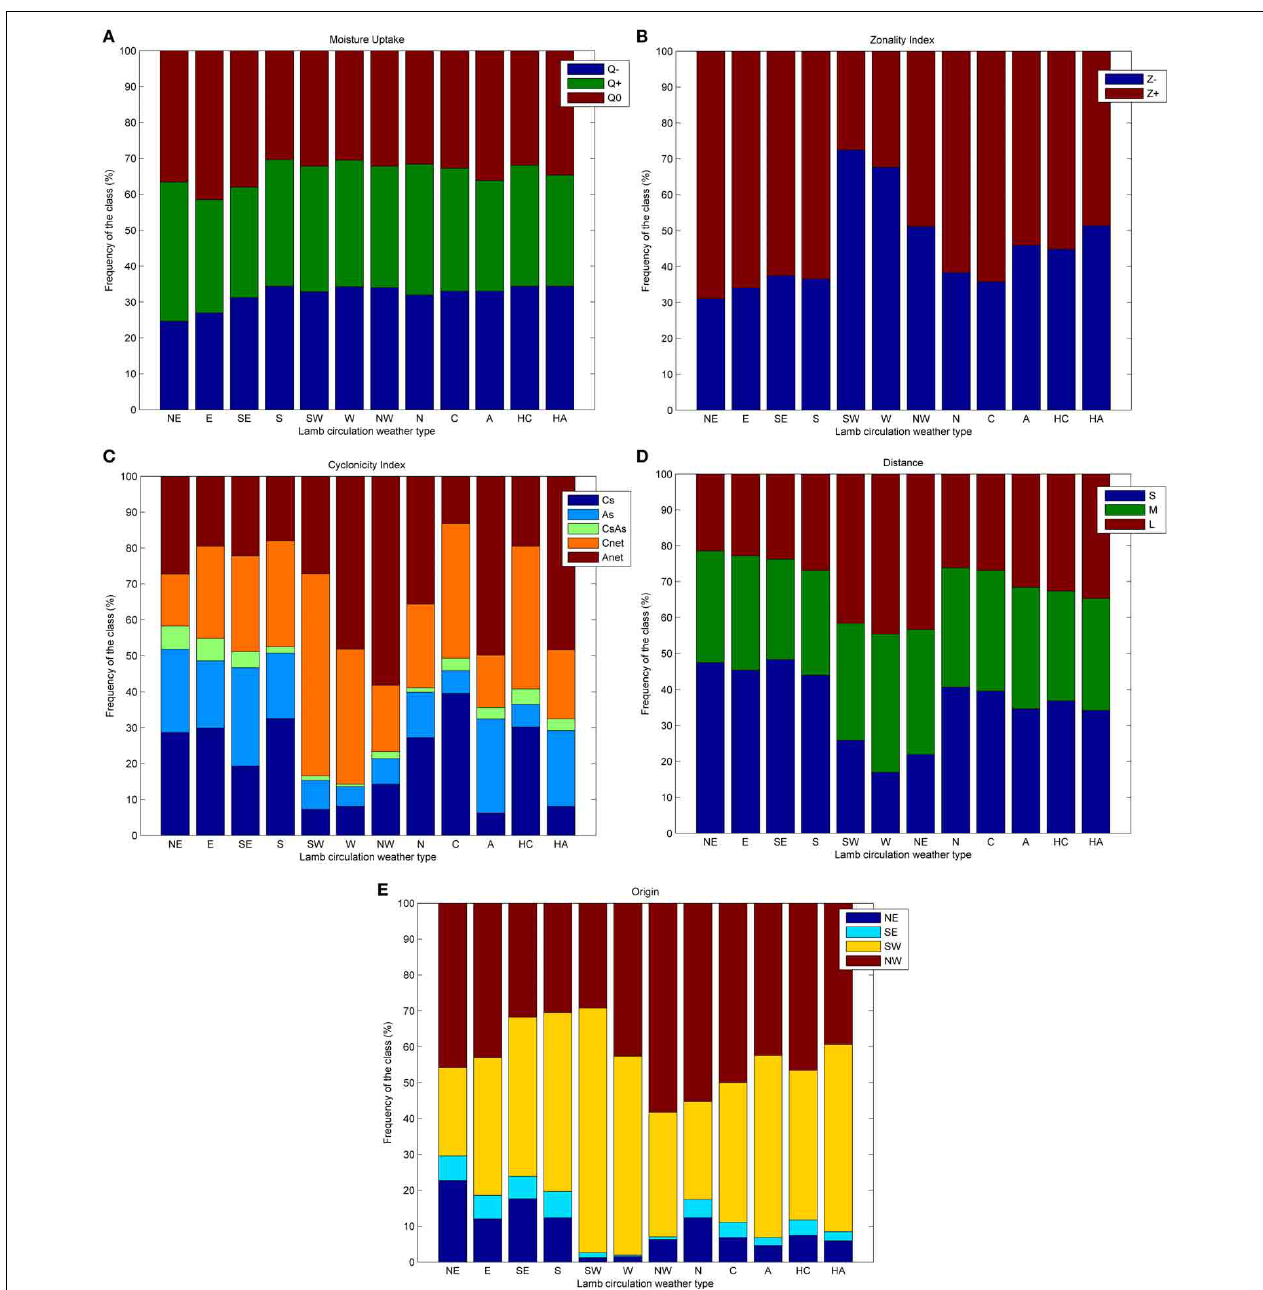
FIGURE 11 | Relationship between Lamb circulation weather type and the Lagrangian flow properties (A) MU, (B) ZI, (C) CI, (D) D, and (E) O. Each column correspond to the frequency (%) of each class when a certain Lamb circulation weather type